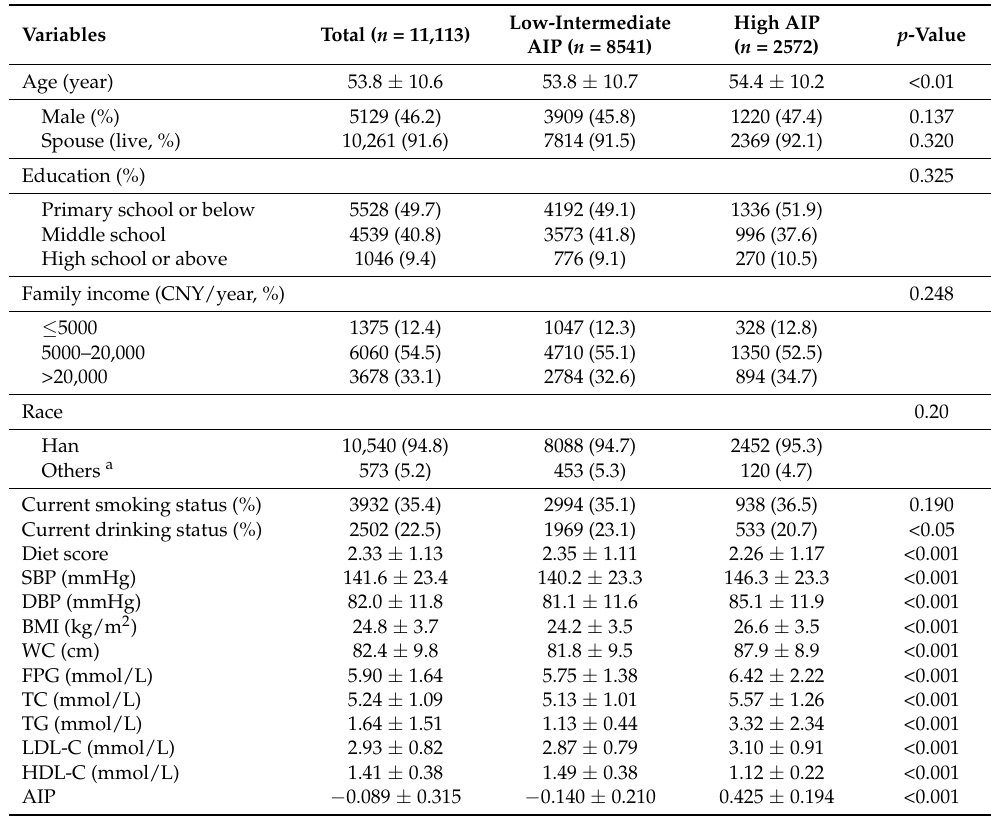
Table 1. Baseline characteristics of study